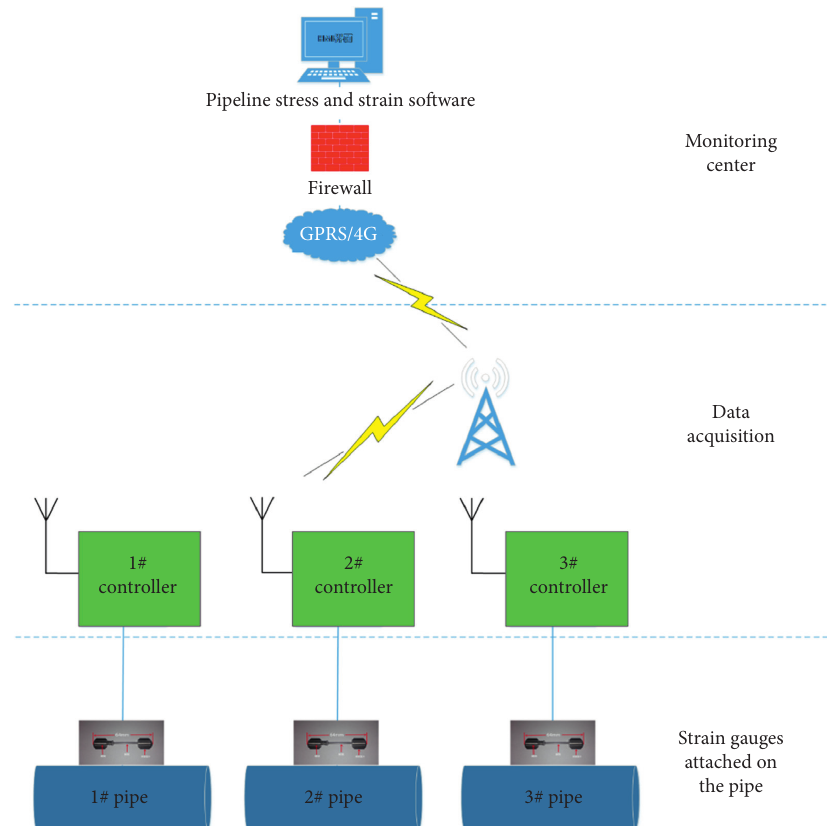
Figure 1: Schematic of pipeline stress monitoring system architecture.